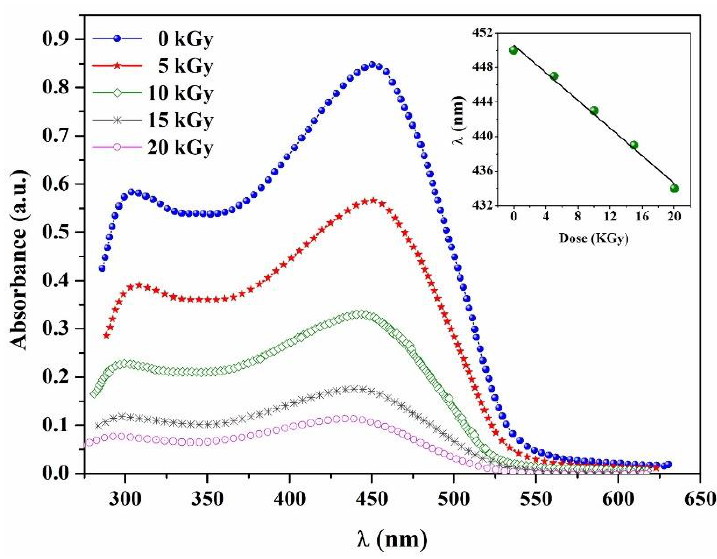
Figure 2. UV – vis absorption spectra of B-co-MP in THF at a concentration of 1 µM at different Figure 2. UV–vis absorption spectra of B-co-MP in THF at a concentration of 1 µ M at different gamma doses. gamma